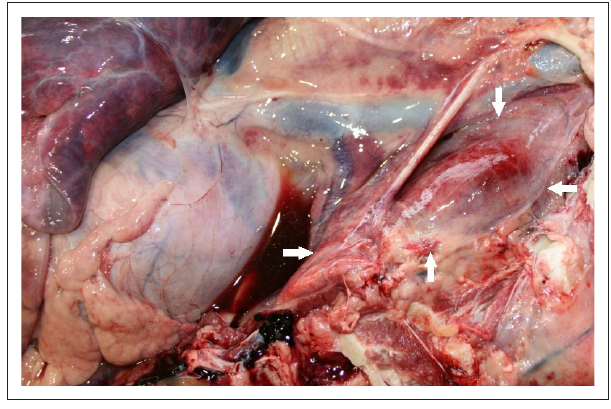
White arrows, indicates the borders of the tumour. FIGURE 3: Cranial thorax of the lion with the right thoracic wall removed and the right cranial lung lobes reflected